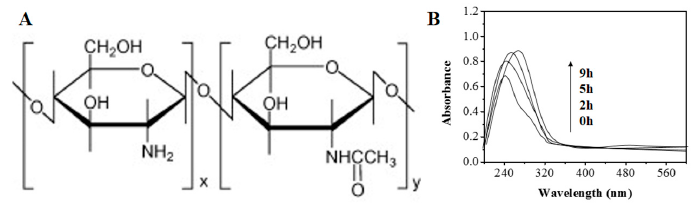
Figure 1. ( A ) Chemical structure of chitosan (CS); ( B ) UV-vis absorption spectra of the reduced graphene oxide (RGO) recorded at various times.